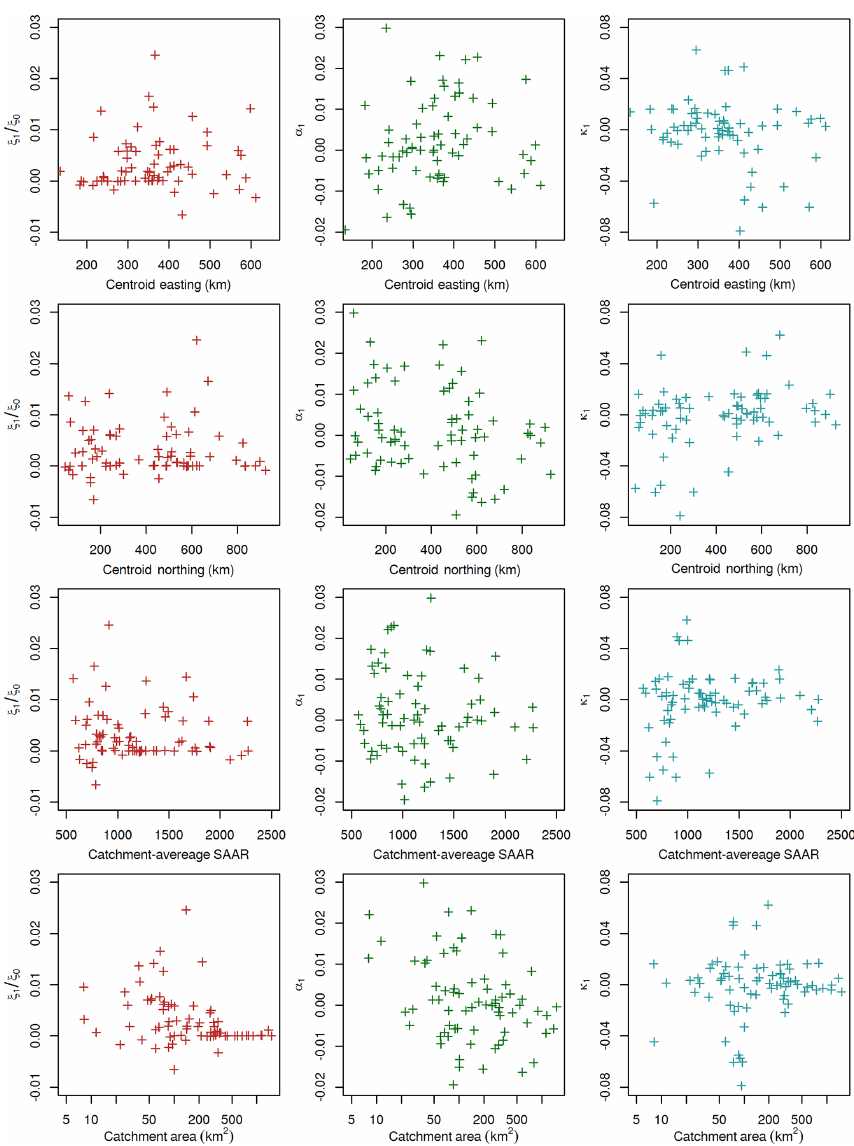
Figure 7. Scatterplots plotting catchment descriptors against relative trends in non-stationary